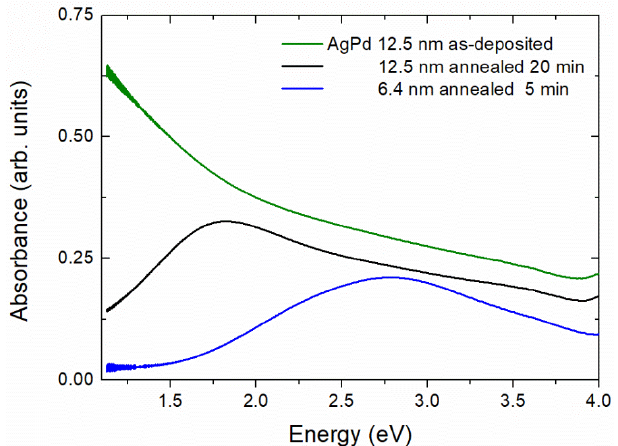
Figure 5. Absorbance spectra for thin AgPd alloyed films on Corning glass annealed at 460 °C in air. One may see broad LSPRs with maxima close to the position of Ag NPs one, compare to Ref.